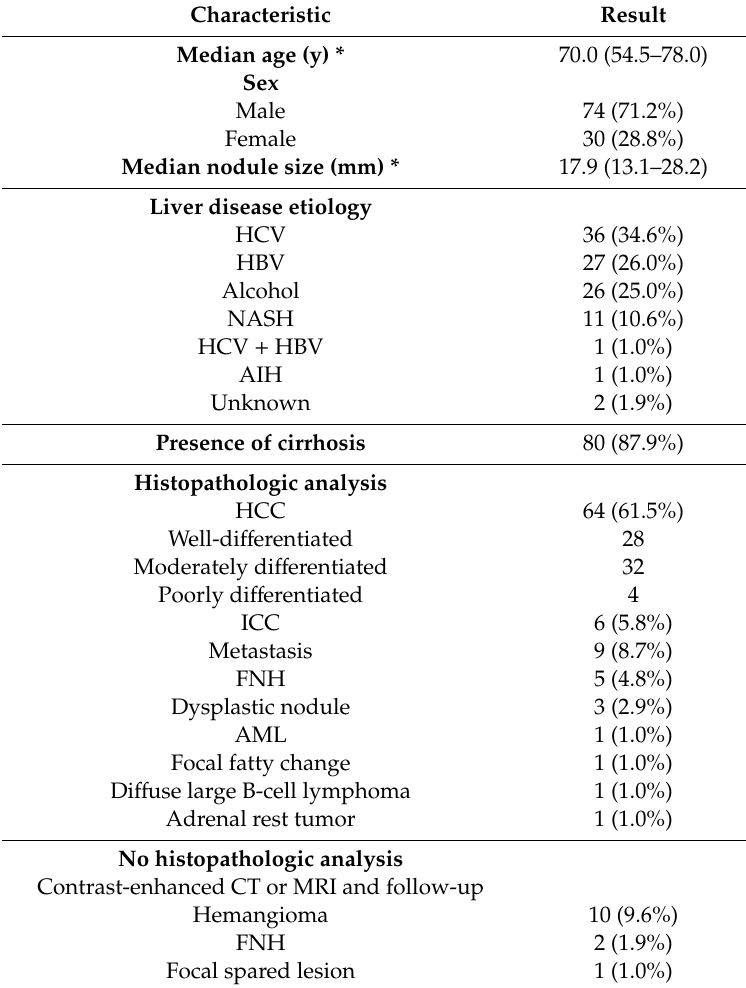
Table 2. Clinical and histopathologic